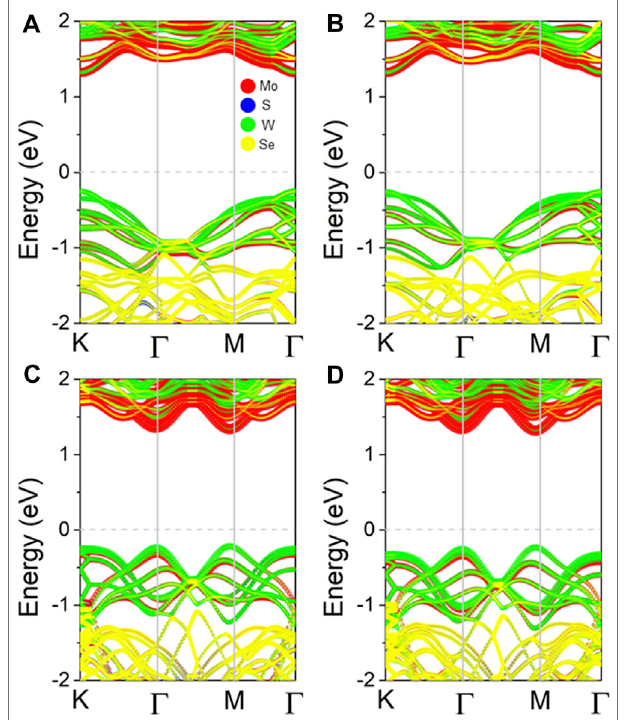
FIGURE 3 | Projected band structures of the (A) arm-1, (B) arm-2, (C) zig-1, and (D) zig-2 MoSSe/WSSe heterostructures.